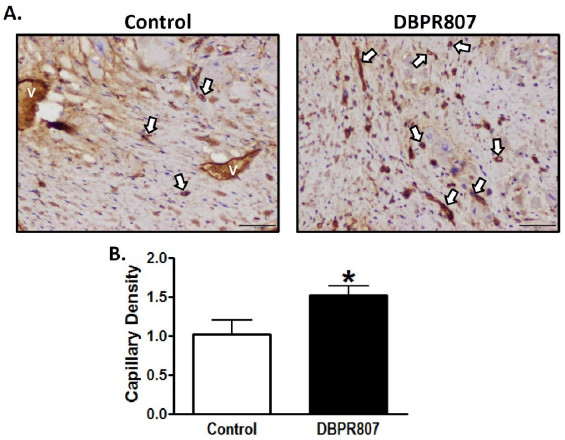
Figure 6. DBPR807 mitigated the reduction in capillary density after IR injury in the mini-pig model. Mini-pigs were treated with or without DBPR807 (IV, 3 mg/kg) after balloon-induced IR injury ( n = 10 per group). ( A ) Isolectin B4 was stained 12 weeks after IR injury and capillaries are labeled in brown (white arrows); V represents vein; scale bar = 50 μm on 200× field. ( B ) The density of isolectin B4 + stain was quantified to determine capillary density. The data are presented as mean ± SEM. Statistical analysis was performed by t -test: * p < 0.05.